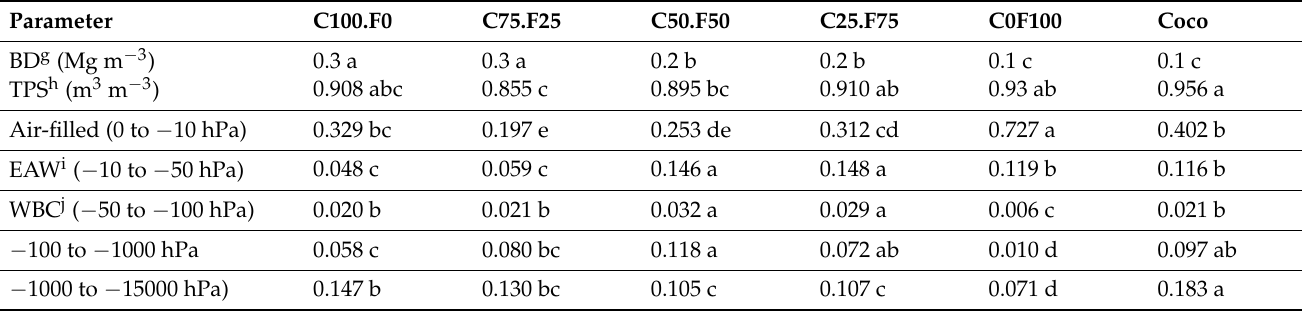
Table 2. Selected physical properties of treatments in Experiment 1.